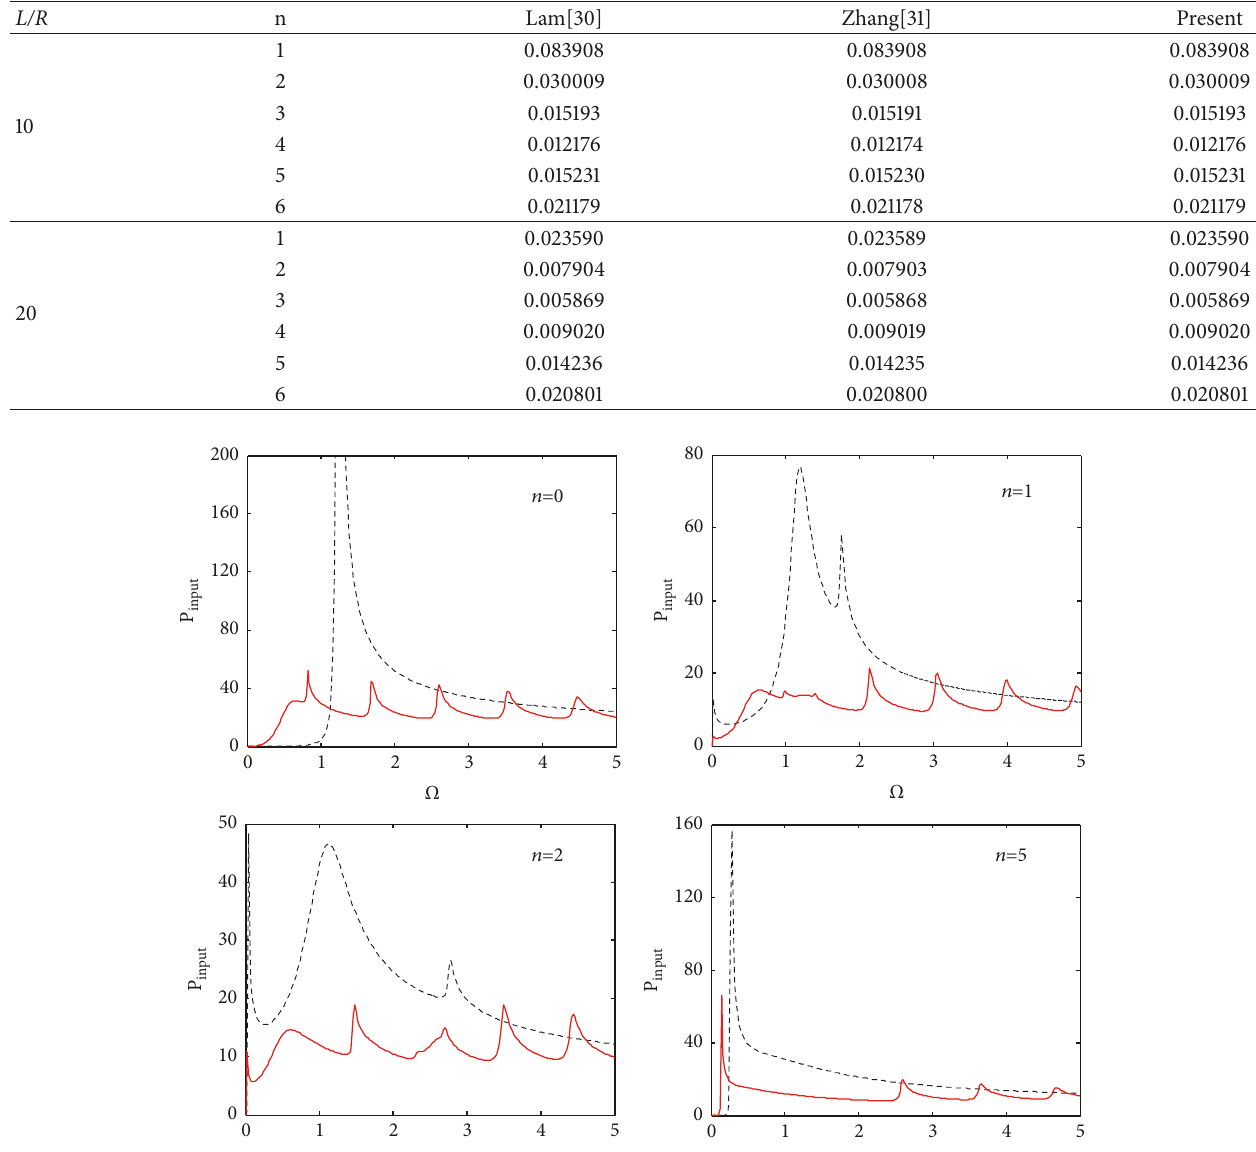
Table 1: Comparison of the frequency parameters for a three-layered, cross-ply [0 ∘ /90 ∘ /0 ∘ ] cylindrical shell with SS boundary conditions ( h / R = 0.002, FL = 0).